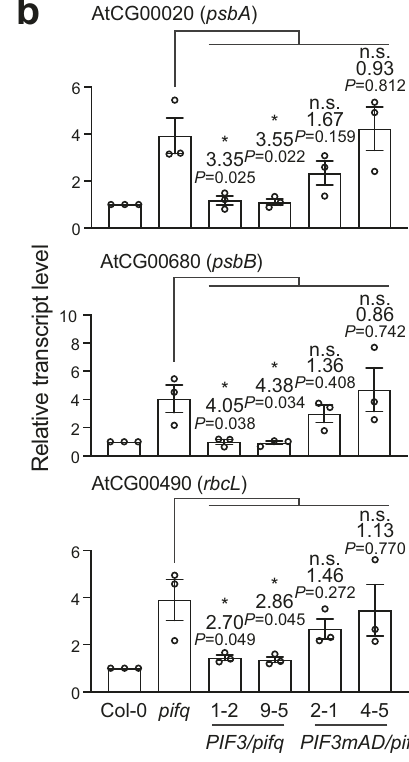
Fig. 6 | PEP inhibition requires PIF3 ’ s transactivation activity. a Immunoblots showingthelevelsofthePEPcomplexanditscorecomponentrpoBin4-d-oldCol- 0, pifq , PIF3/pifq (lines 1-2 and 9-5), and PIF3mAD/pifq (lines 2-1 and 4-5) seedlings grown in the dark. Total protein was isolated under either native or denaturing conditions and resolved viaBN-PAGEorSDS-PAGEto assessthe fractionofrpoBin the PEP complex or the amount of total rpoB by immunoblots, respectively. Actin wasusedasaloadingcontrol.Thegraphbelowtheimmunoblotsshowstherelative PEPlevels,whichwereestimatedusingtherelativelevelofrpoBinthePEPcomplex (BN-PAGE) divided by the relative level of denatured rpoB (SDS-PAGE) in each sample. Different letters denote statistically signi fi cant differences in the relative PEP levels (ANOVA, Tukey ’ s HSD, P ≤ 0.05, n =3). Error bars represent the s.e. of